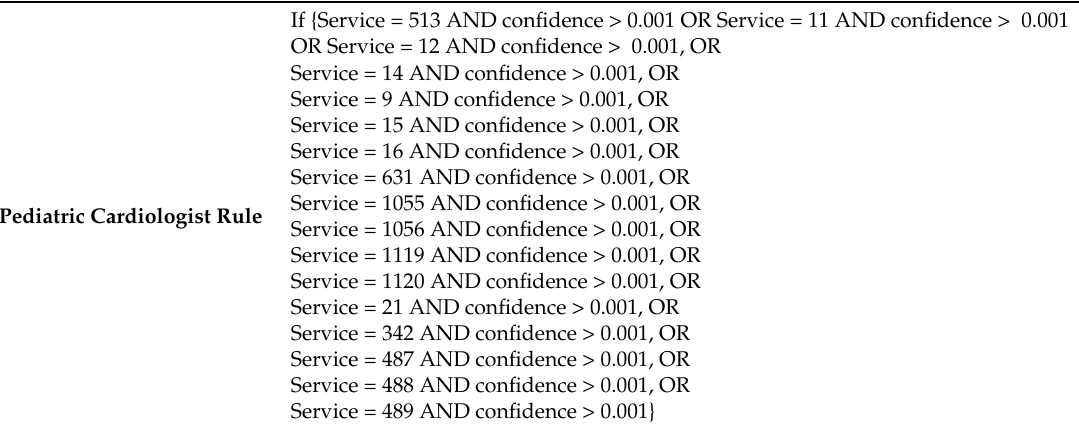
Table 7. Rule for Pediatric Cardiologist extracted from Table